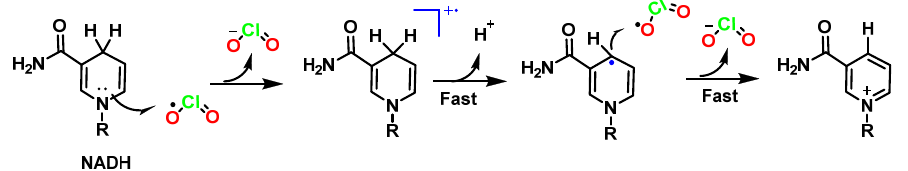
Figure 42. Proposed mechanism of NADH oxidation by ClO 2 .